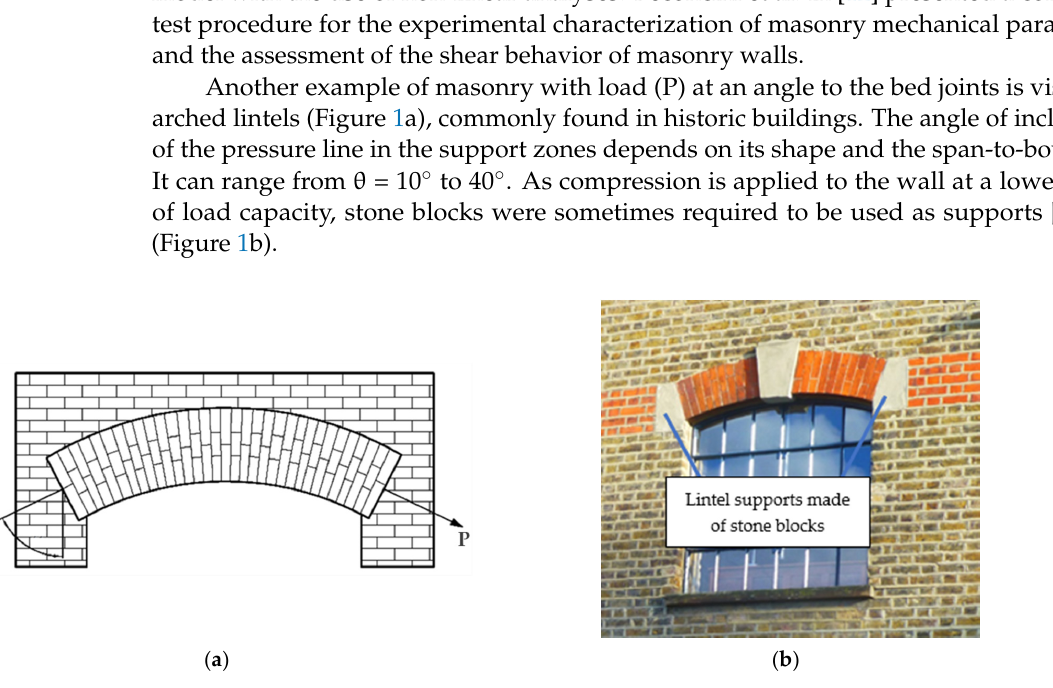
Figure 1. Examples of arched lintels ( a ) diagram with load (P) acting at an angle to the joints; ( b ) image of an arched lintel with stone blocks in support zones.